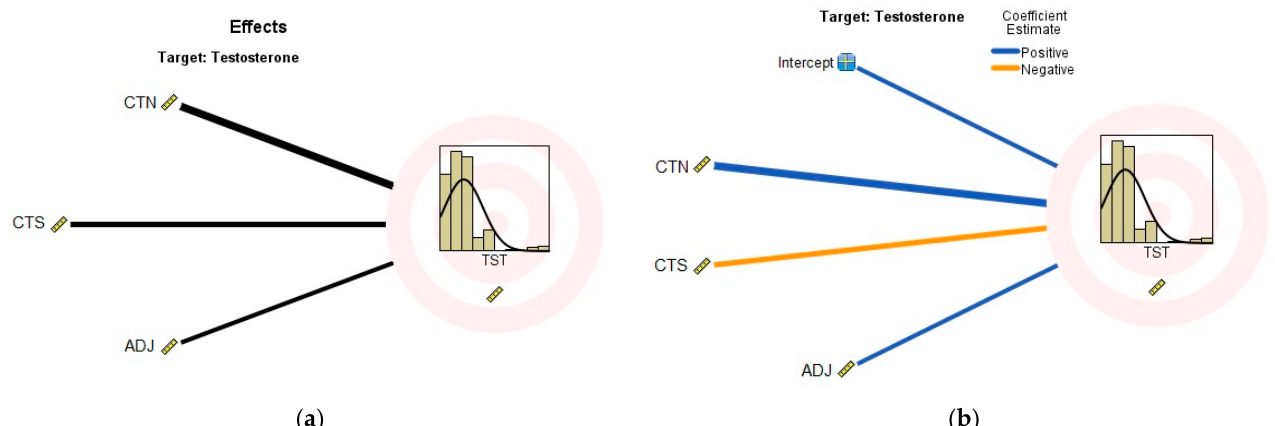
Figure A4. The forward stepwise model selection method results presented for Model 4 after automatic linear modelling: ( a ) the identified effects for the predictors on testosterone (TST) levels by cortisone (CTN), task cohesion (CTS), and adaptation to the new military environment (ADJ) and ( b ) the negative and positive coefficient estimations that were identified in Model 4 for cortisone (CTN), task cohesion (CTS), and adaptation to the new military environment (ADJ).